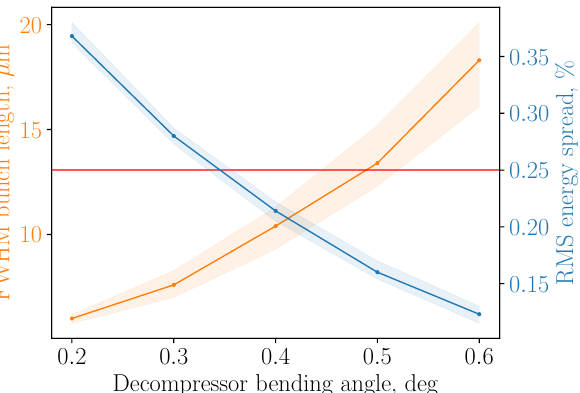
Figure 3. FWHM bunch length (orange) and slice RMS energy spread (blue) as a function of the decompressor bending angle. The solid lines represent the case for the bunch charge of 35 pC. Shaded areas represent the bunch charge variation in the range of (25–45) pC. The initial projected RMS energy spread is equal to